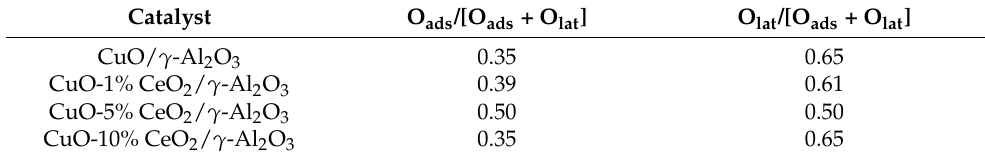
Table 3. The various oxygen ratios of CuO/ γ ‐ Al 2 O 3 and CuO ‐ CeO 2 / γ ‐ Al 2 O 3 . Catalyst